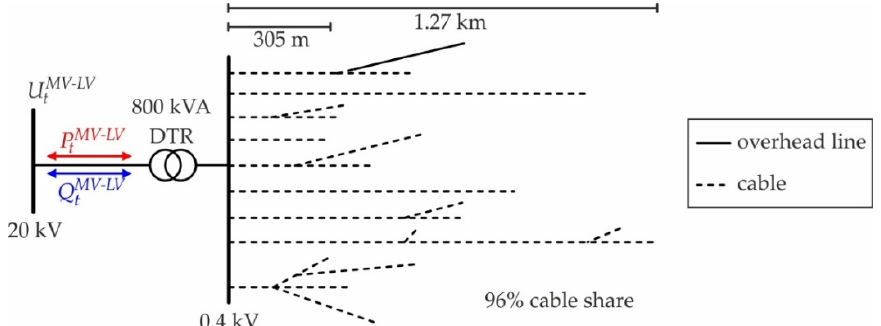
Figure A3. Simplified one-line diagram of the urban LV grid.